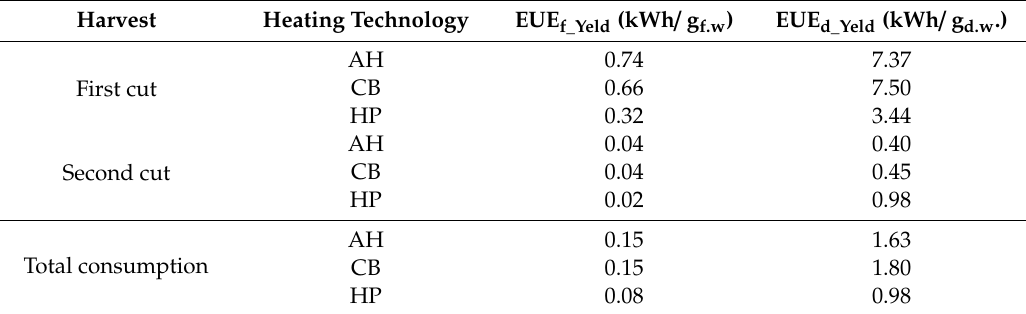
Table 8. Kilowatt-hours expended for gram of harvested biomass. CB: condensing boiler; AH: air heater; HP: heat pump; EUE f_Yeld : Energy-use e ffi ciency expressed for fresh weight of harvested plant biomass; EUE d_Yeld : Energy-use e ffi ciency expressed for dry weight of harvested plant biomass; g f.w . grams of fresh weight; g d.w. : grams of dry weight.